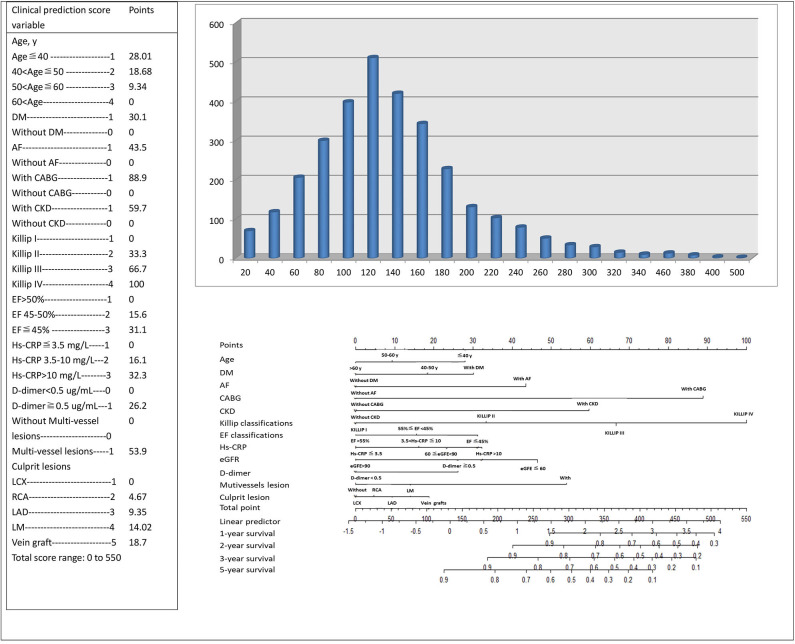
The risk score nomogram for bedside application. Histogram refers to the score distribution in the derivation cohort. For the variables selected in the nomogram model, the values of different variables can correspond to different scores on the integral line at the top of the nomogram (the score range is 0–550 points) through the projection of the vertical line, and the total score can be obtained by adding up the scores corresponding to the values of each variable. The cumulative occurrence probability of MACEs in 3 and 5 years can be obtained from the total score on the prediction line at the bottom of the nomogram.